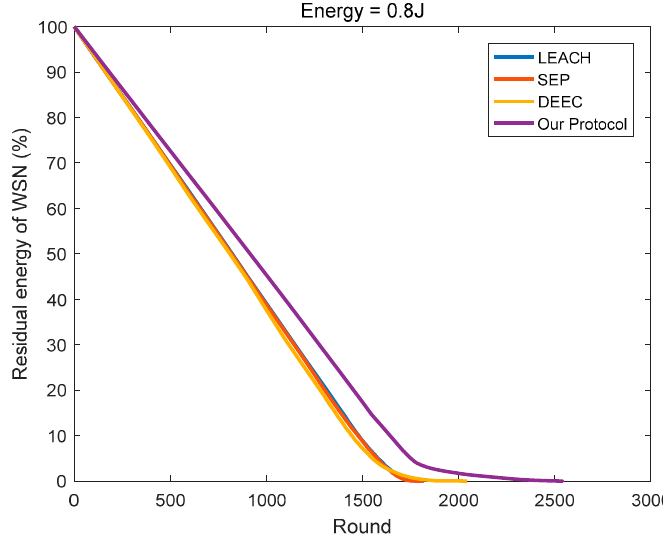
Figure 18. The residual energy varies with the round (initial energy = 0.8 J).